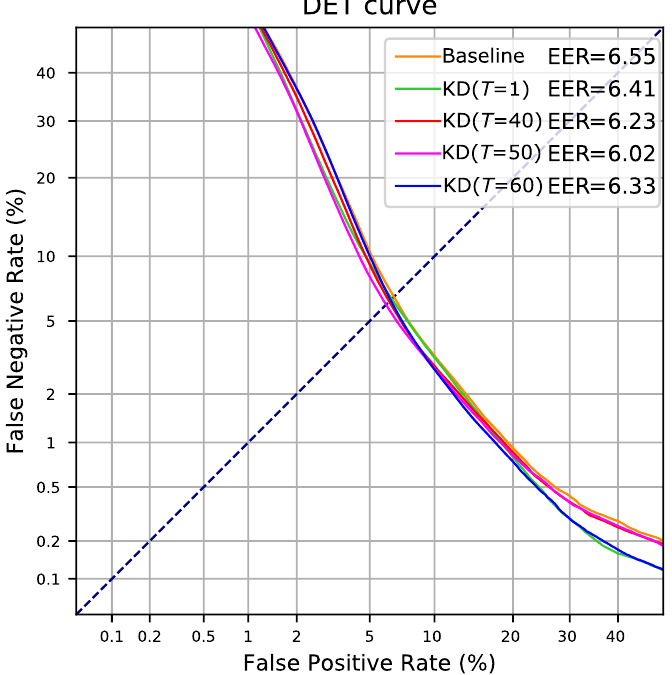
Figure 6. DET curve and EER (%) on the FS02 development partition using the knowledge distillation domain adaptation setup with various softmax temperature values compared to the baseline